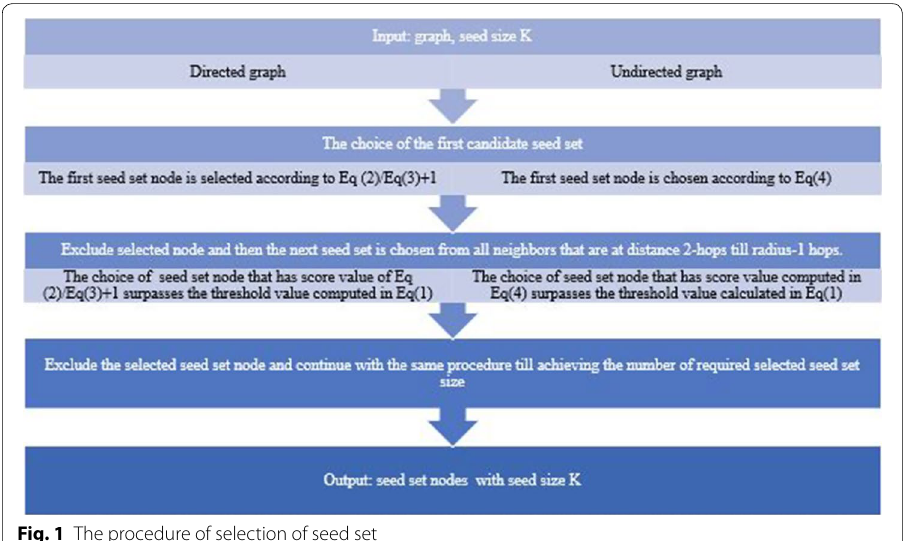
Fig. 1 The procedure of selection of seed